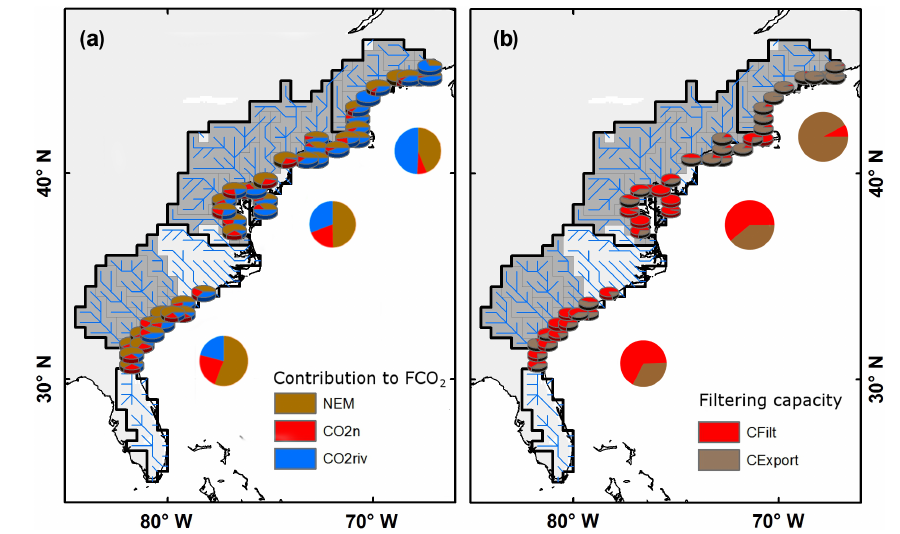
Figure 10. Contribution of NEM, nitrification, and supersaturated riverine waters to the mean annual FCO 2 (a) . Spatial distribution of mean annual carbon filtration capacities (CFilt) and export (CExport) along the US East Coast (b)